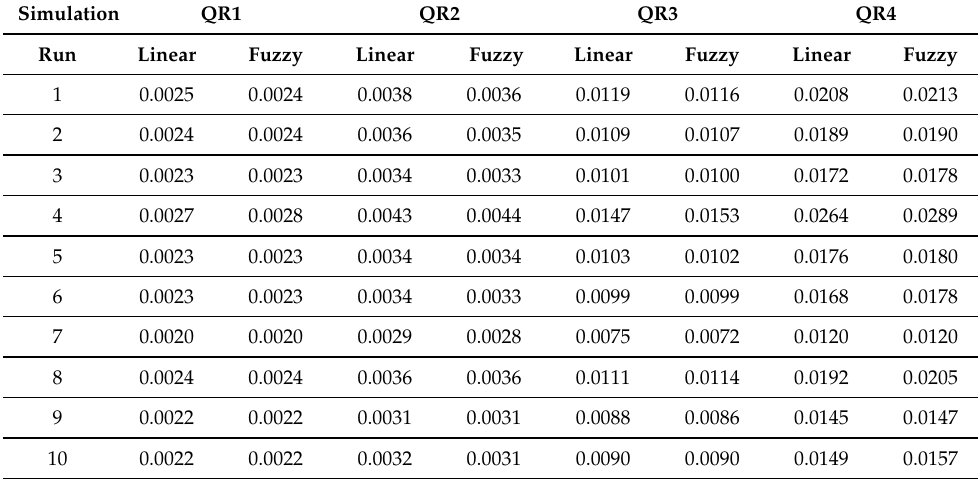
Table 6. Disturbance rejection results of J T for 10 simulations.